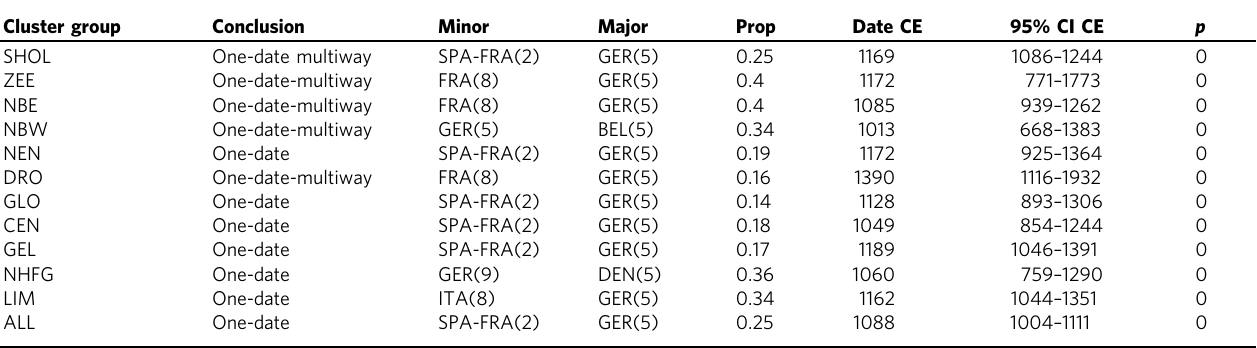
Minor and Major represent inferred proxy admixing sources. Prop represents estimated minor admixture proportion. Admixing sources are derived from ChromoPainter/ fi neSTRUCTURE clustering of 4514 European reference individuals (Methods); labels represent principal country of origin (SPAin, FRAnce, GERmany, BELgium, DENmark) with cluster numbers arbitrarily assigned within countries. Example coancestry curves are shown in Supplementary Fig.